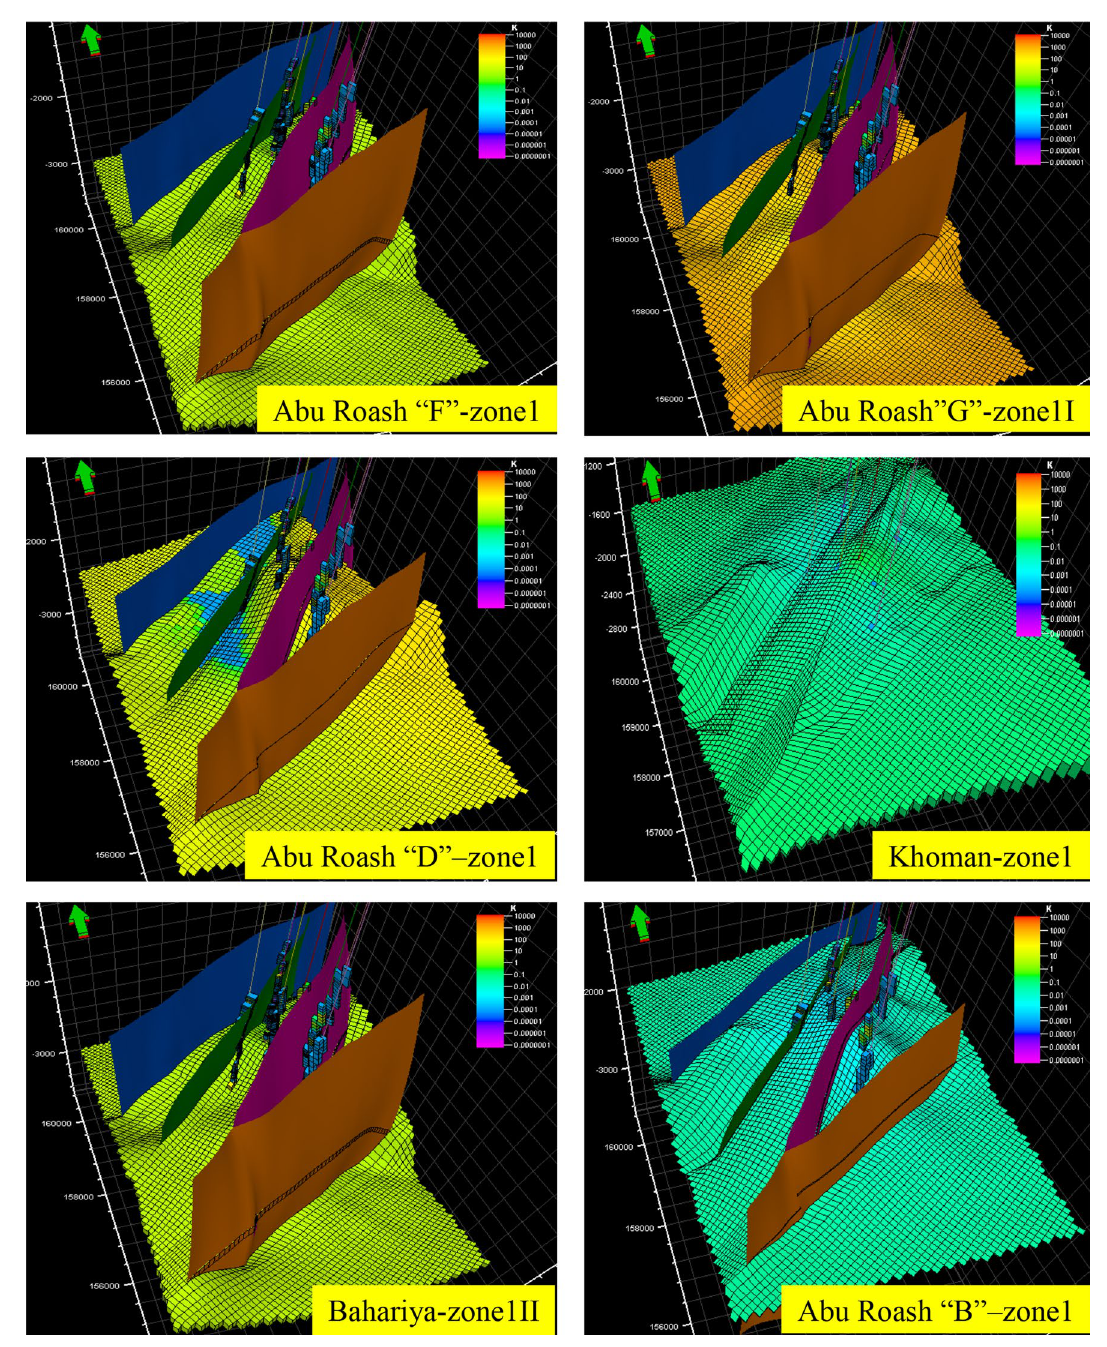
Fig. 17 Permeability model example for the different pay